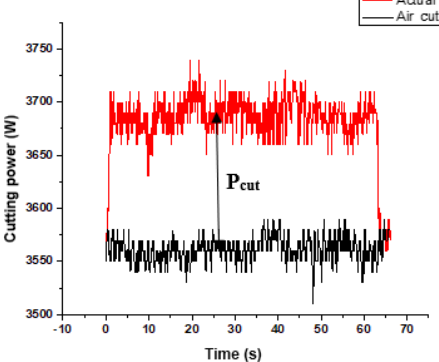
Figure 1. The recorded actual and air cut power to calculate cutting power at cutting condition ( v = 50mmin − 1 , f = 0 . 12mm per rev and d = 1mm).